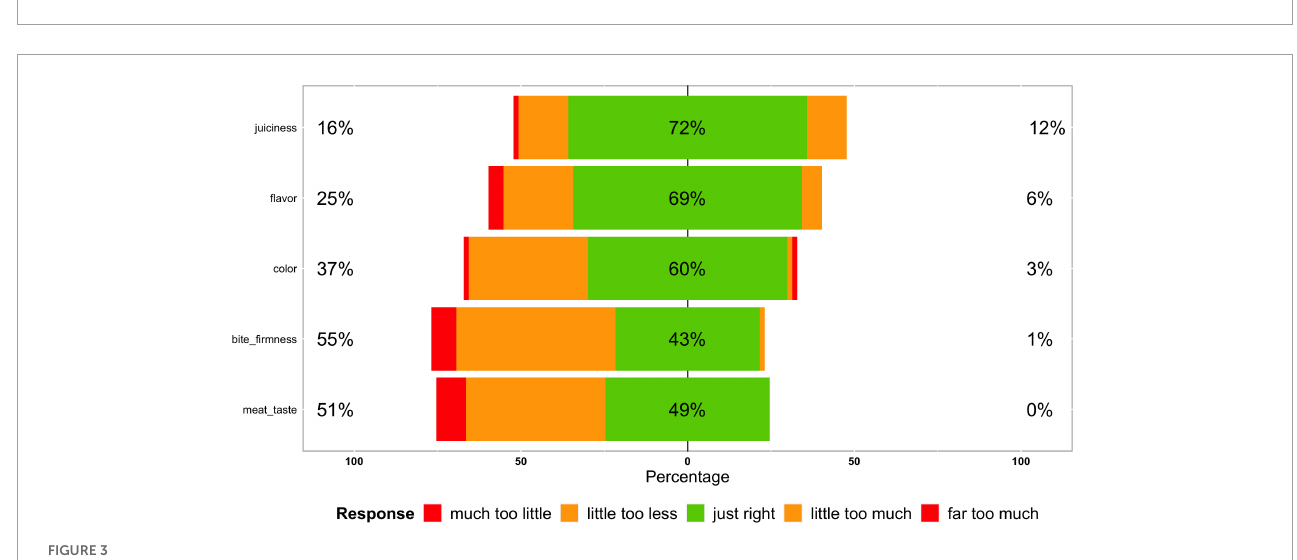
FIGURE3 Sensorial results -